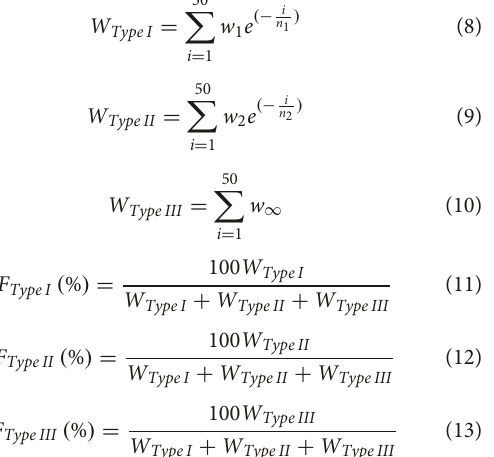
Figure 1A . Two peaks were observed in the molecular